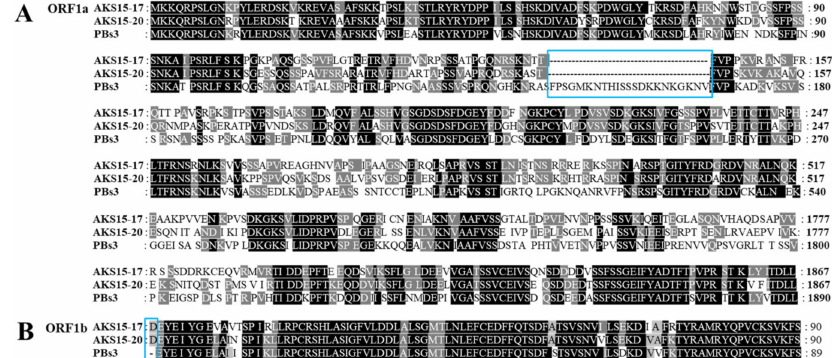
Figure 2. Multiple alignment of partial amino acid sequences of ORF1a ( A ) and ORF1b ( B ) of PAmpV-Ju variants AKS15-17, AKS15-20, and PAmpV isolate PBs3. The deletions are indicated